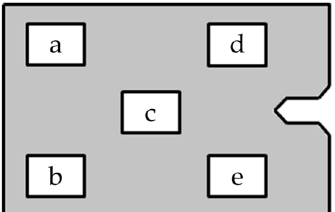
Figure 2. Scheme of the longitudinal section of the fatigue specimens and the five positions ( a – e ) where LOM observations were performed.